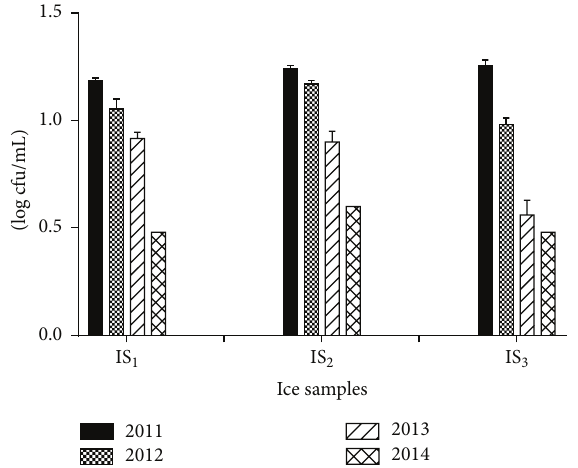
Figure 5: Total viable aerobic count (log cfu/mL) of ice samples. The data were representatives of the three independent experiments using triplicate samples and mean ± SD values were